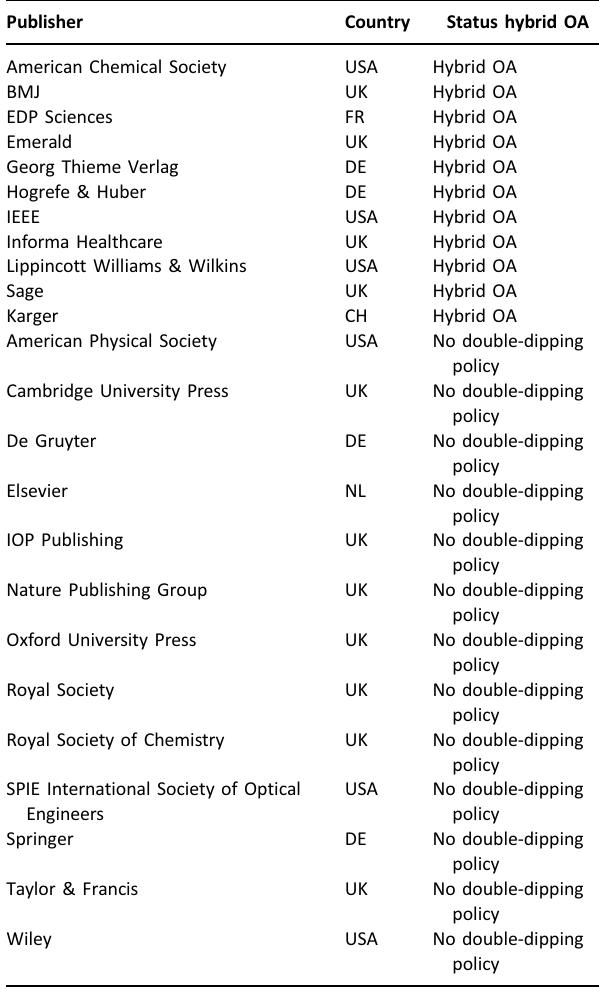
Table 1 . Publishers evaluated and their status with respect to hybrid open access according to details provided on their